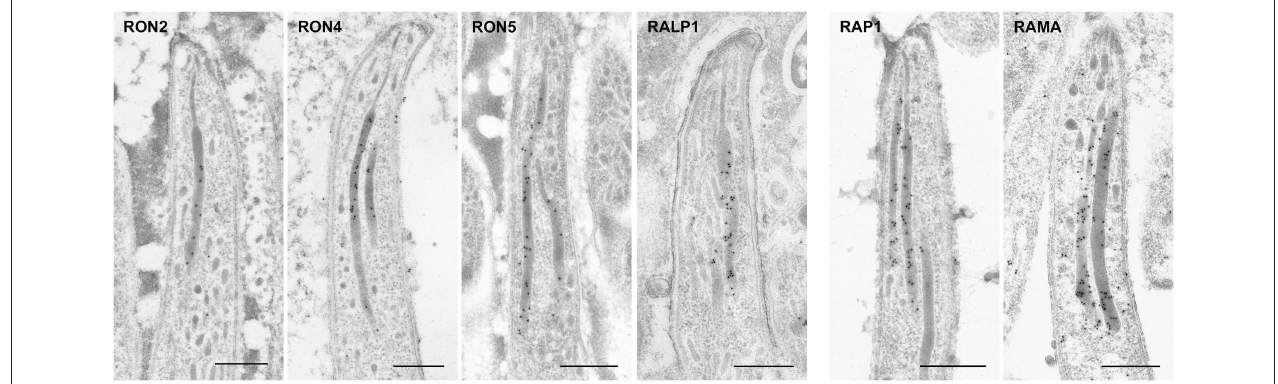
FIGURE 5 | Localization of rhoptry proteins in sporozoites residing in mosquito salivary glands. Salivary glands of parasite infected mosquitoes were harvested at day 24 or 26 post-feeding and fixed for IEM. Target proteins were detected by anti-c-Myc antibodies or specific antibodies against ASP/RON1 or RAMA. All examined rhoptry proteins, despite their sub-localization in merozite rhoptries, are distributed throughout rhoptries in sporozoites residing in salivary glands, as well as oocyst-derived sporozoites. Bars, 500nm.